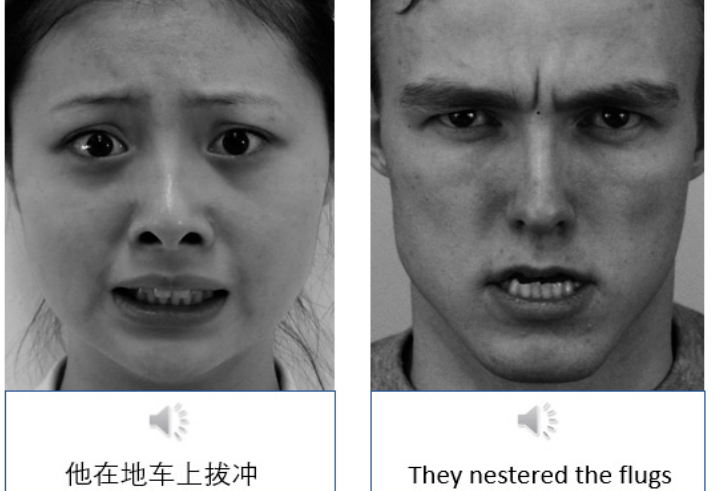
Figure 1. An example of bimodal stimuli from each culture. In the left-hand panel, an Asian face is paired with meaningless Mandarin speech (East Asian culture). In the right-hand panel, a Caucasian face is paired with meaningless English speech (Western culture). (Asian face—Image ID fea118: Adapted with permission from Chen and Yen (2007); Mandarin pseudo-sentence: Adapted with permission from Liu and Pell (2012); Caucasian face—Image ID AM08ANS: Adapted with permission from Lundqvist et al. (1998); English pseudo-sentence: Adapted with permission from Pell et al. (2009).)